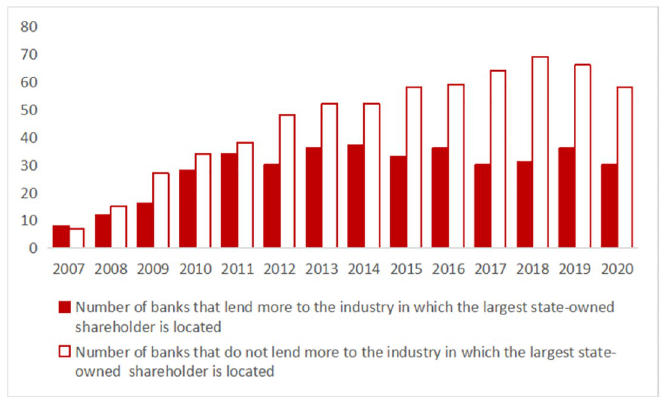
Fig 2. Number of banks that lend more to the industry in which the largest state-owned shareholder is located. The figure plots the number of banks that lend more to the industry in which the largest state-owned shareholder is located (solid bars) vs. the number of banks that do not lend more to the industry (hollow bars) for each year. Based on the proportion of banks’ loans to various industries, we define that banks have made more loans to the top five industries, otherwise, they have